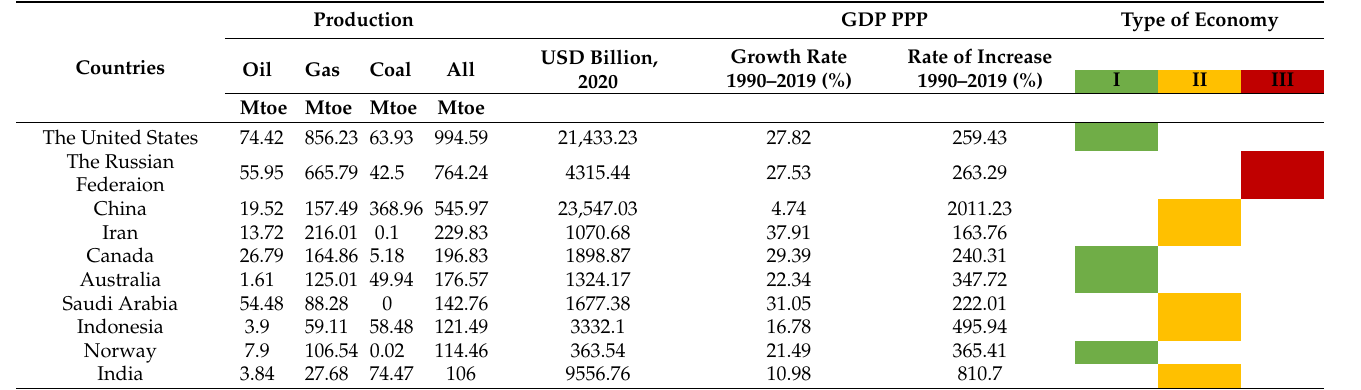
Table 1. The role of emerging economies in the global production of energy [33–35].